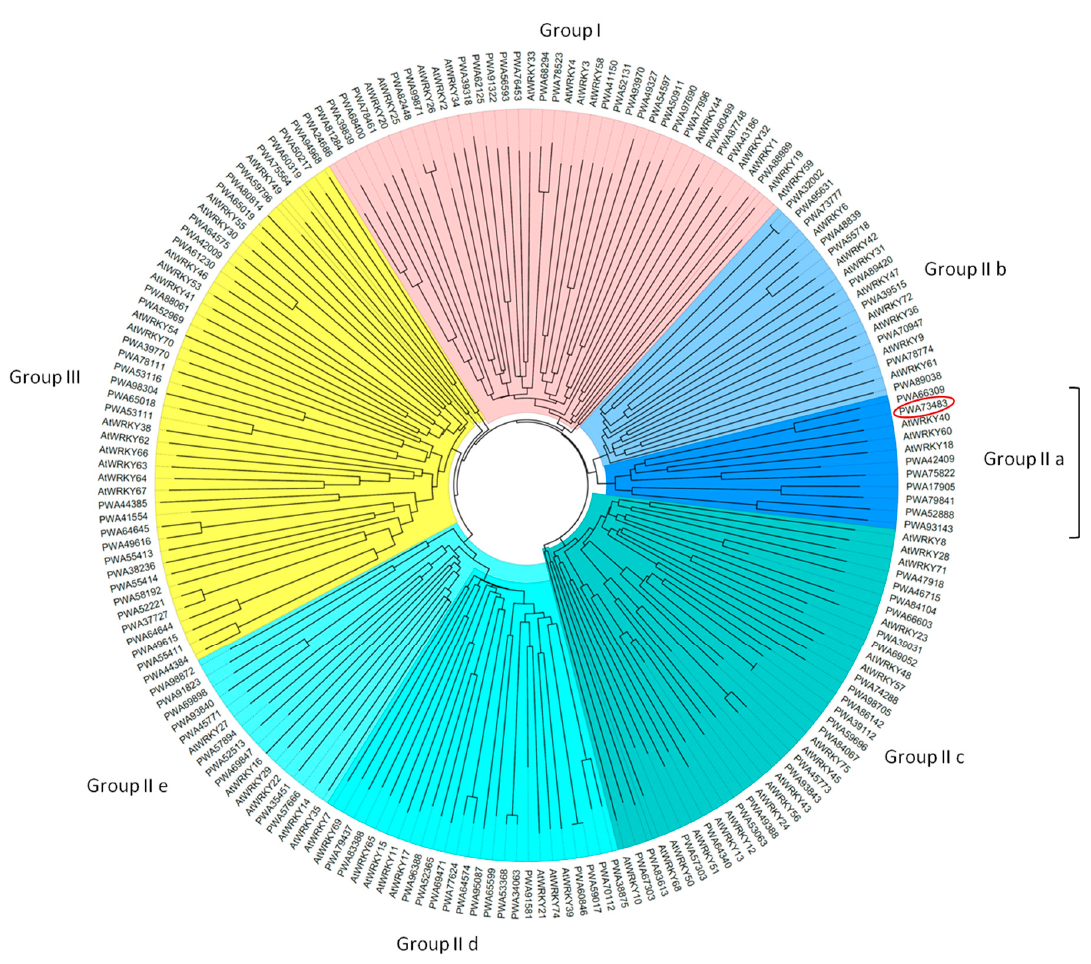
Figure 5. Phylogenetic tree of WRKY proteins from A. annua and A. thaliana . The complete amino acid sequences of 122 A. annua and 71 Arabidopsis WRKY proteins were aligned, and the phylogenetic tree constructed with 1000 bootstrap replicates, using Muscle EMBL-EBI analysis tool [35] followed by visualization with FigTree (http://tree.bio.ed.ac.uk/software/figtree/). WRKY groups and subgroups are highlighted with different colors: pink for group I, gradation of blue for group II, yellow for group III. The protein corresponding to the cloned AaWRKY40 gene is circled in red.